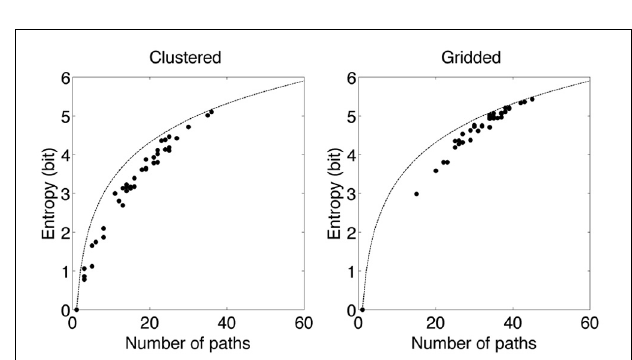
FIGURE 6 | T 50 vs. Entropy determined from gridded AOIs (left panel) vs. T 50 vs. Entropy determined from clustered AOIs. Each data point represents data from 48 observers in one ad. Both T 50 and entropy values differ for the 2 AOI production methods. However, in both cases T 50 and Entropy have a high correlation.